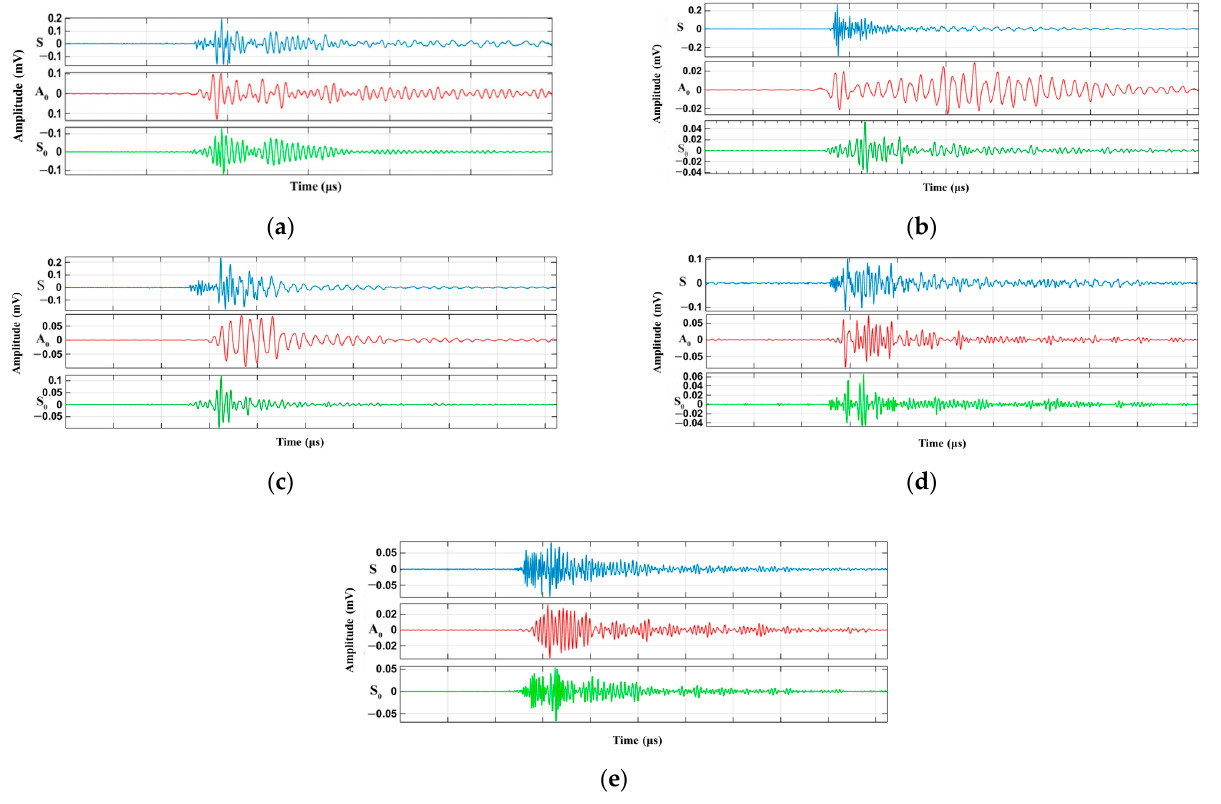
( b ) Figure 7. Signal modal component waveform diagram: IP source ( a ), OP source ( b ). 3.2. Mode Analysis of Delamination Damage By using the EMD mode separation method presented in Section 3.1, the modal char- acteristics of the AE signals generated during the loading of laminates were separated, and the modal characteristics of signals S 0 and A 0 at each stage of P 1 –P 5 were extracted. The results of different stages of loading according to Figure 2b are shown in Figure 8a– e. It can be seen from Figure 8a–e that the modal characteristics of all the five stages P 1 –P 5